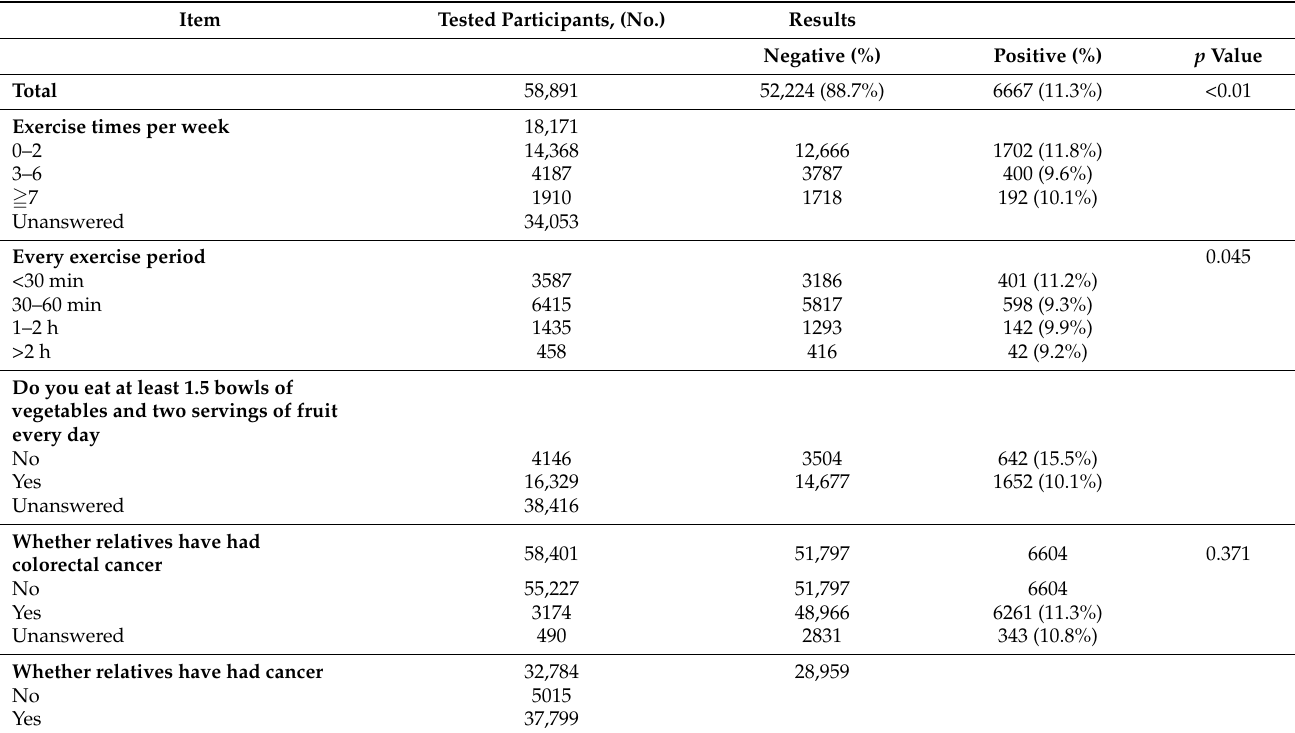
Table 3. Statistical analysis of participants’ health behaviors and FOBT screening results.